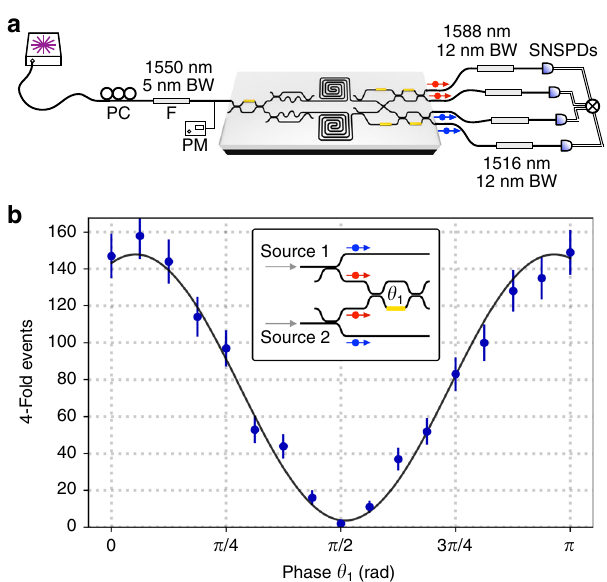
Fig. 3 Heralded Hong-Ou-Mandel interference. a Experimental setup for 4-photon heralded HOM experiments. b Heralded HOM results. Points are raw four-photon counts measured over 4-h of integration time each for different values of the MZI phase θ , with a solid line fi t to the data, presenting a visibility of 0.96(2). Error bars represent 1 s.d. and consider Poissonian photon statistics. Inset: schematic of the integrated circuit con fi guration for measuring the heralded HOM